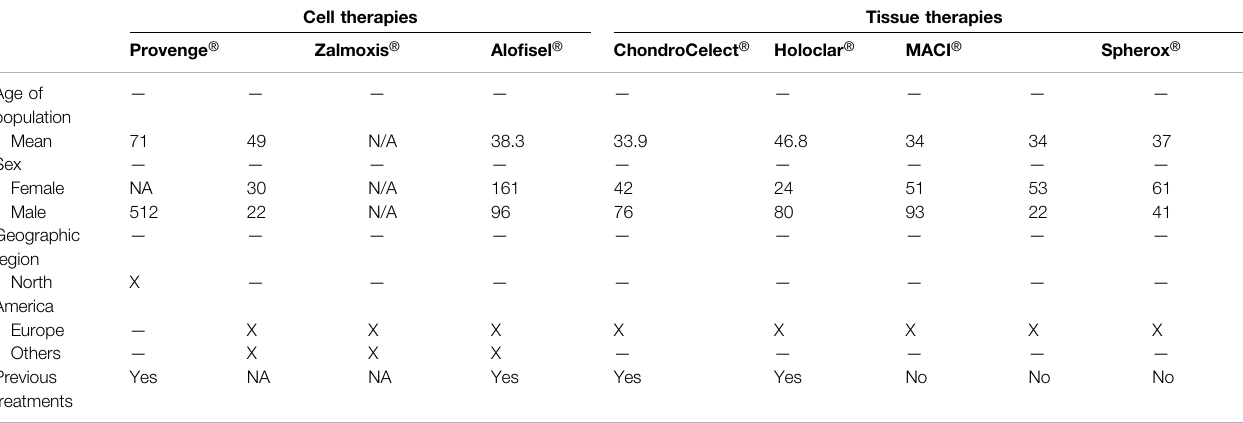
TABLE 4 | ( Continued ) Design features of pivotal clinical trials for the approved cell and tissue engineered therapy medicinal products in the European Union. Cell